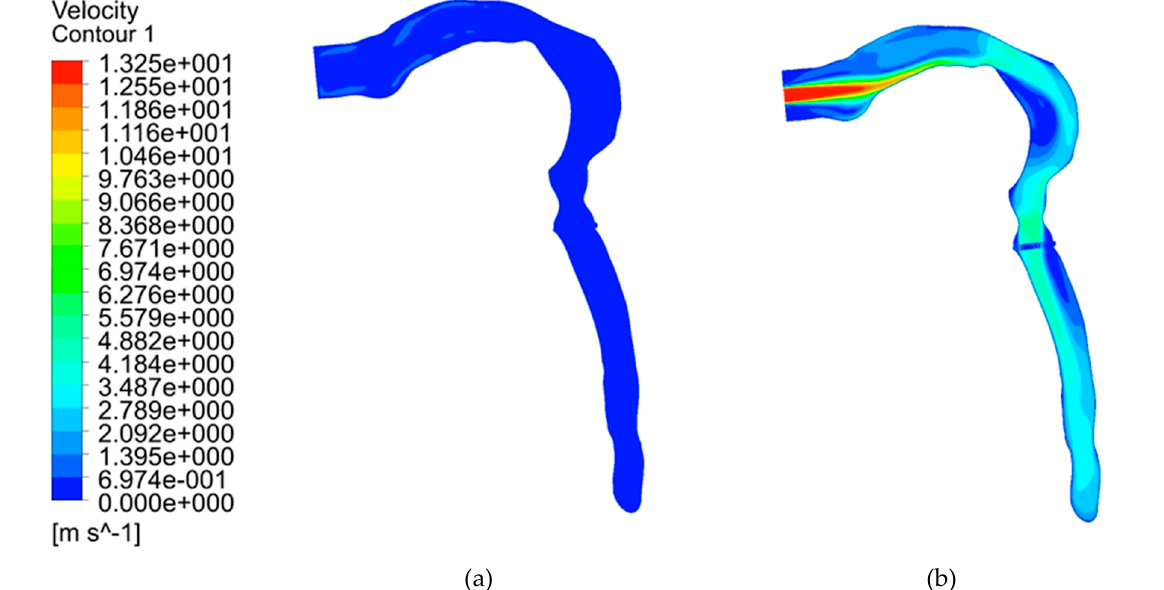
Figure 7. Velocity contours at ( a ) constant puffing condition and for ( b ) fresh air inhalation during post-puffing condition.